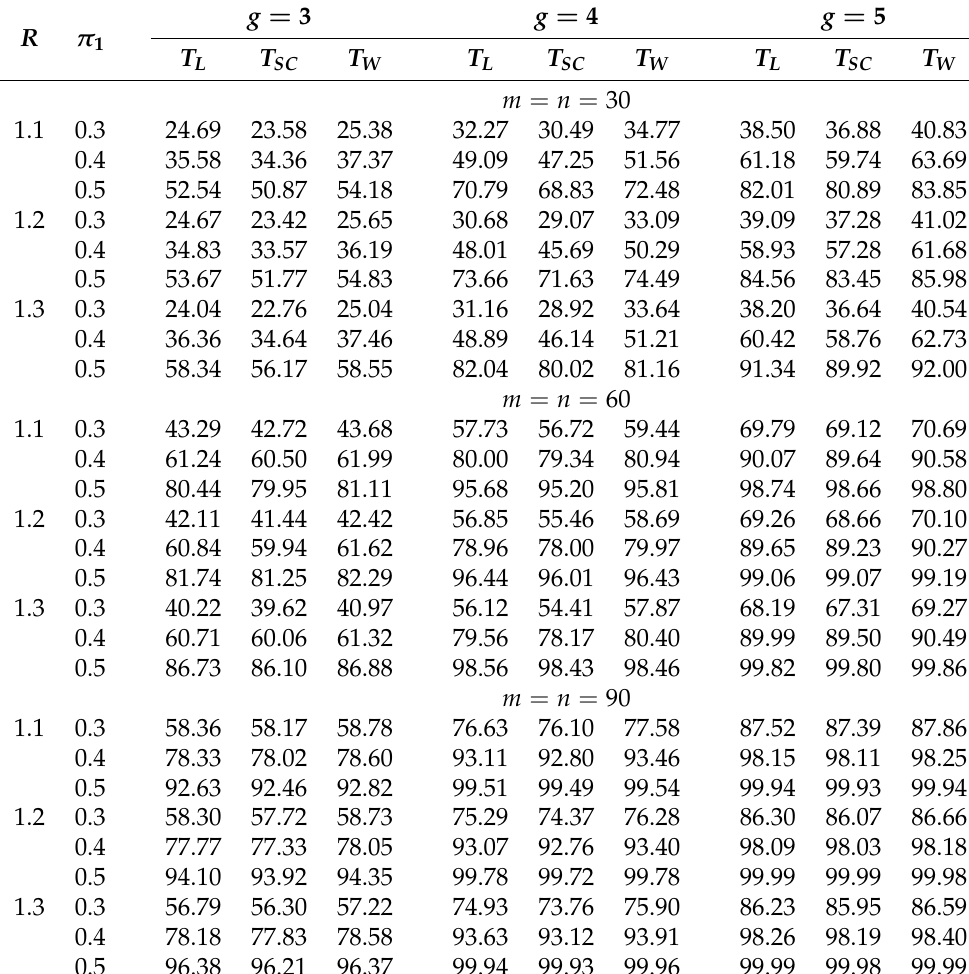
Figure 1. Empirical TIEs of tests. Table 6. The power (%) of the balance group ( α =